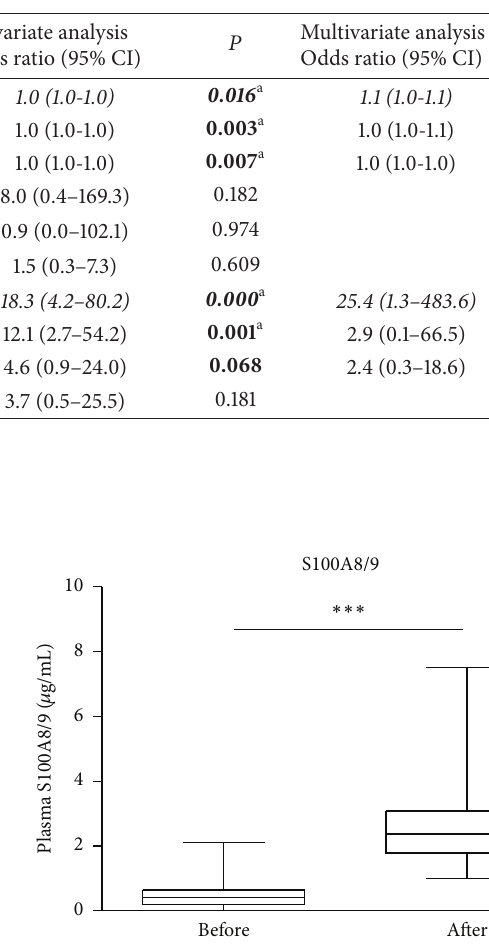
Table 3: Binary logistic regression analysis of hospital length of stay with patient characteristics, operative variables, and postoperative outcomes a .